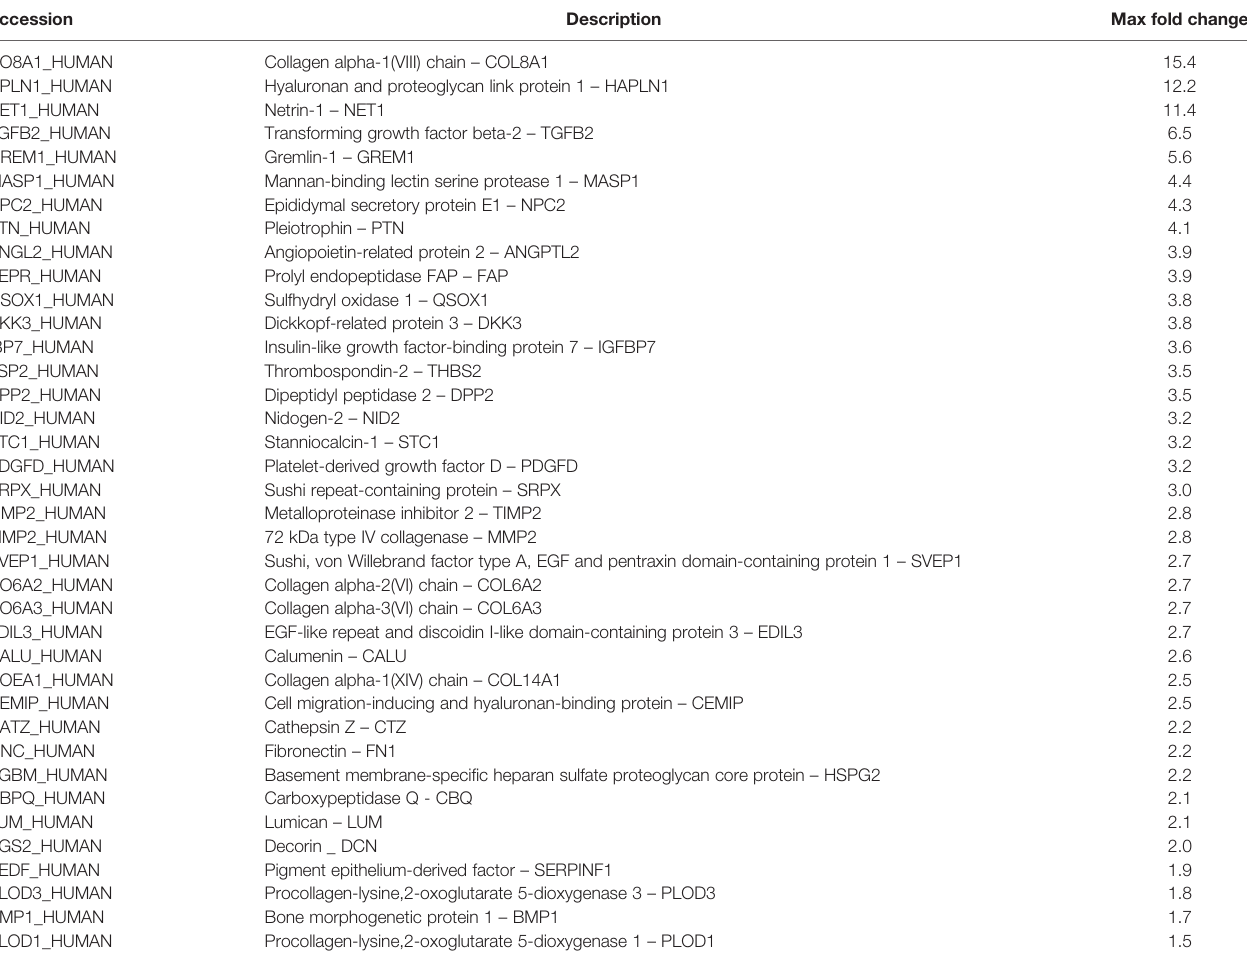
TABLE 4 | More abundant classically secreted proteins found in ERS CM.